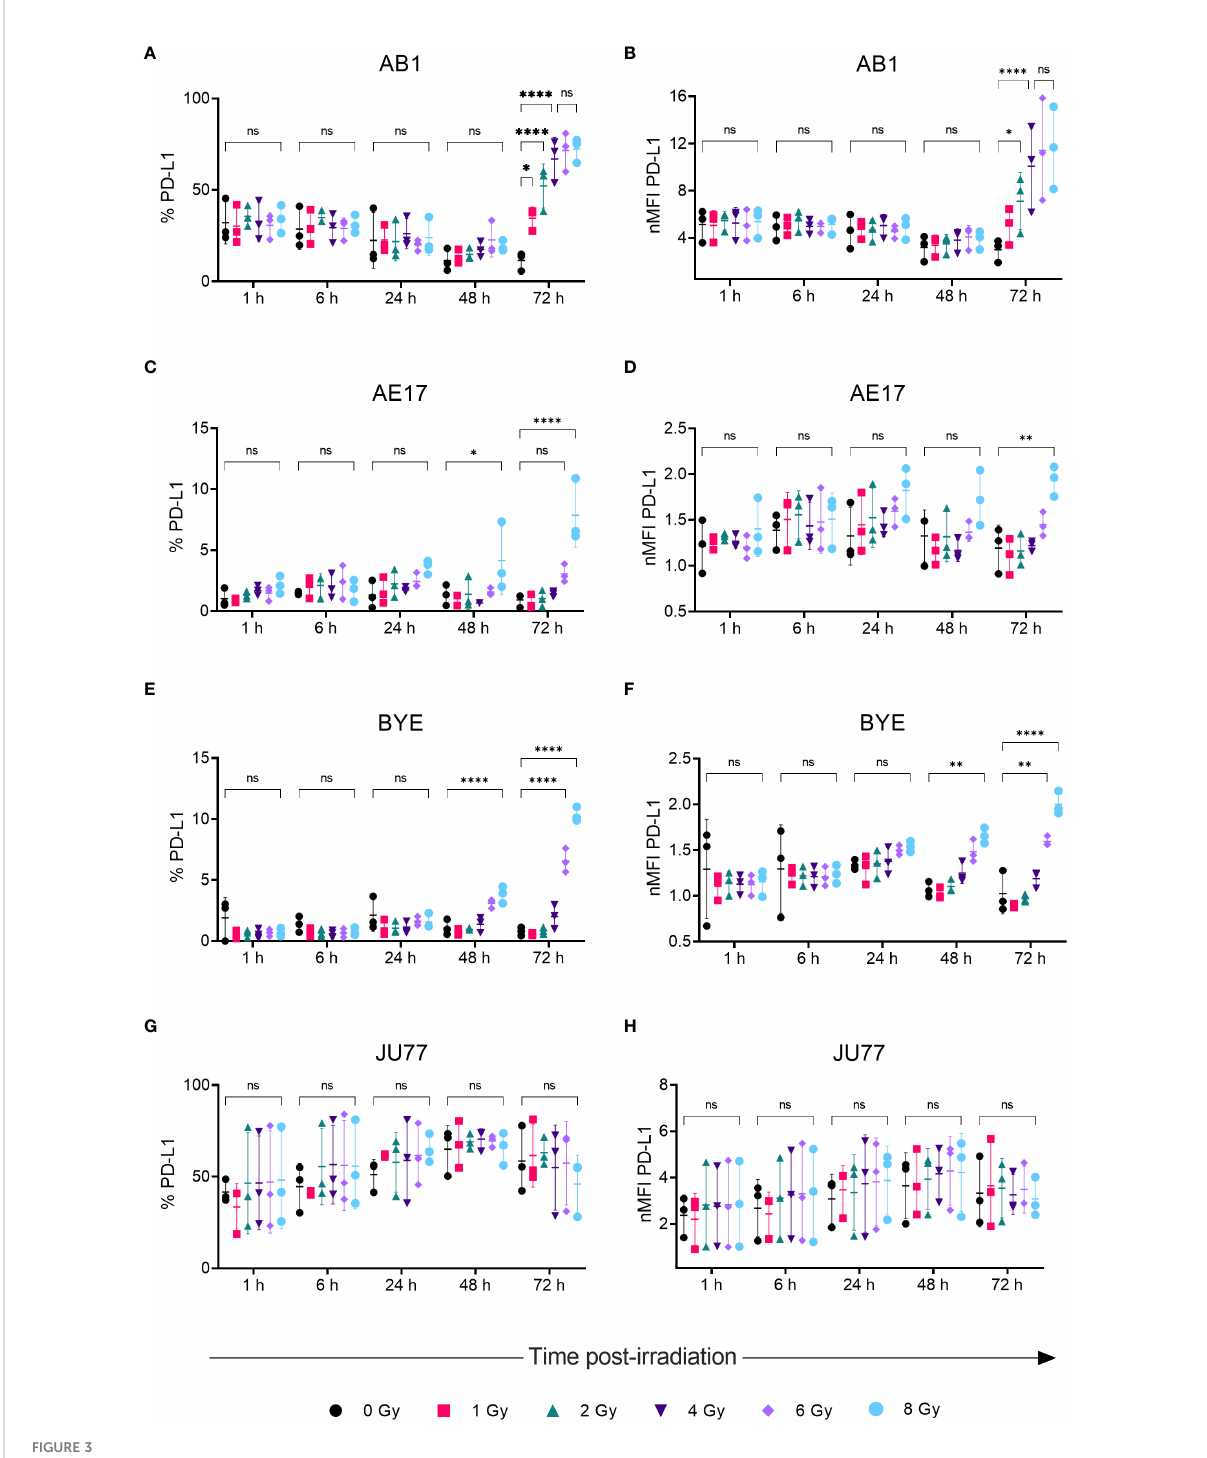
FIGURE 3 Radiation increases PD-LI expression on mesothelioma cells in a dose- and time-dependent manner. (A – H) Mesothelioma cells were irradiated with 0-8 Gy and changes to the percentage of PD-LI positive cells and nMFI over time (1, 6, 24, 48 and 72 h) were determined by fl ow cytometry for AB1 (A, B) , AE17 (C, D) , BYE (E, F) and JU77 (G, H) cell lines. Data are presented as mean ± S.D. of n = 3 independent experimental repeats. All p-values were determined by two-way ANOVA and multiple pairwise comparison with Tukey adjustment. P-values are represented as follows: * p < 0.05, ** p < 0.01, **** p < 0.0001. ns, not signi fi